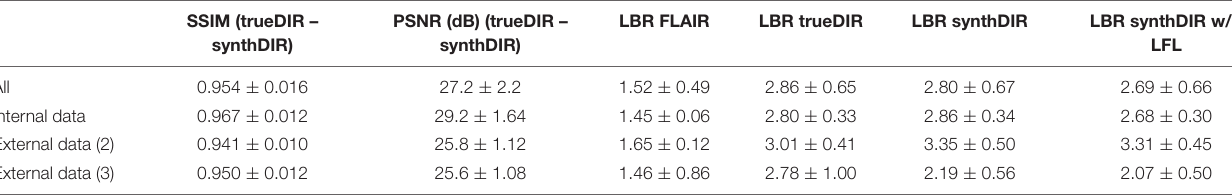
TABLE 4 | Image-wise (SSIM) and voxel-wise (PSNR) comparative metrics for synthDIR and trueDIR.